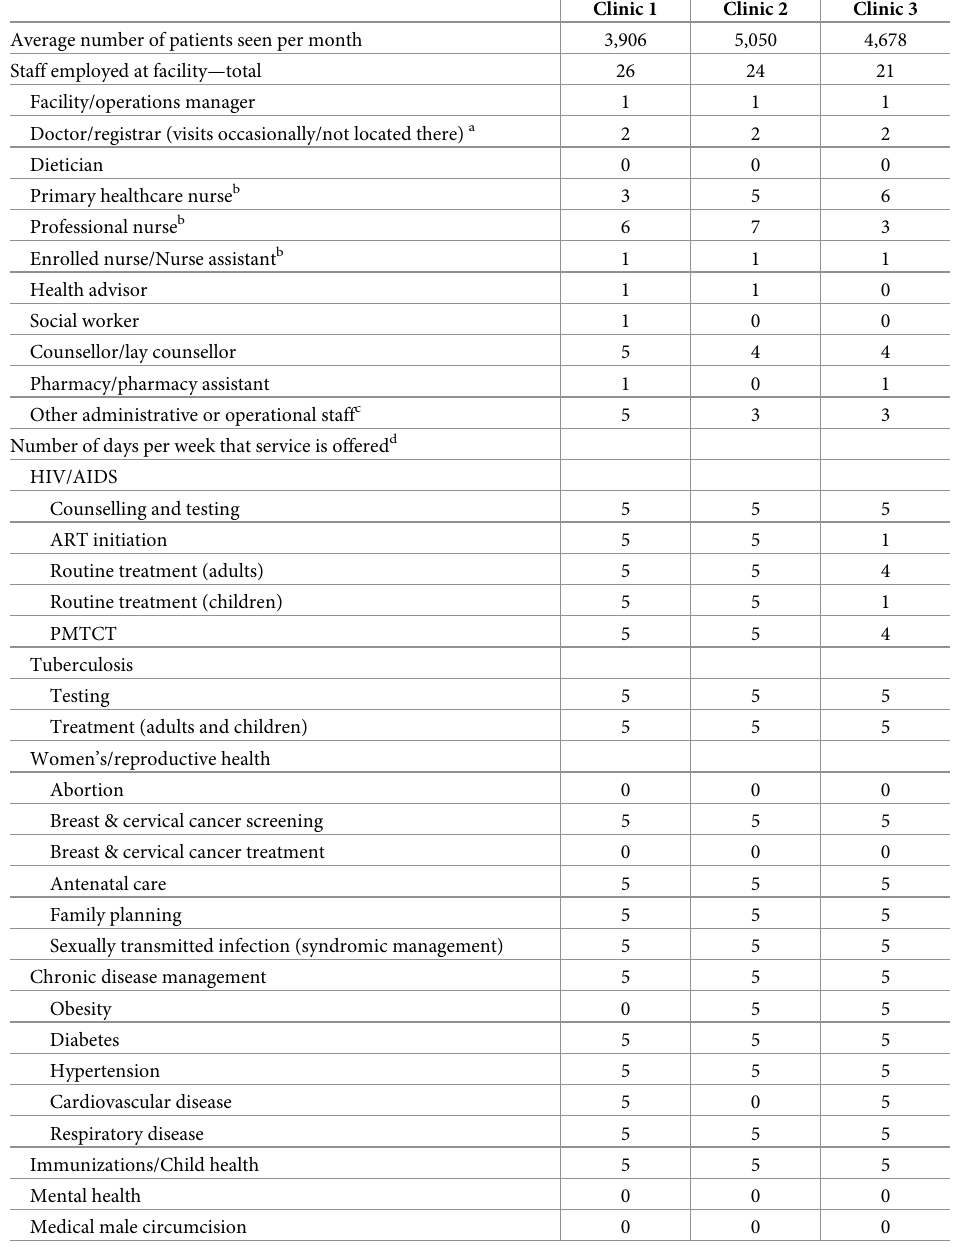
Table 2. Staffing and service at three public clinics in an administrative region of the city of Johannesburg, South